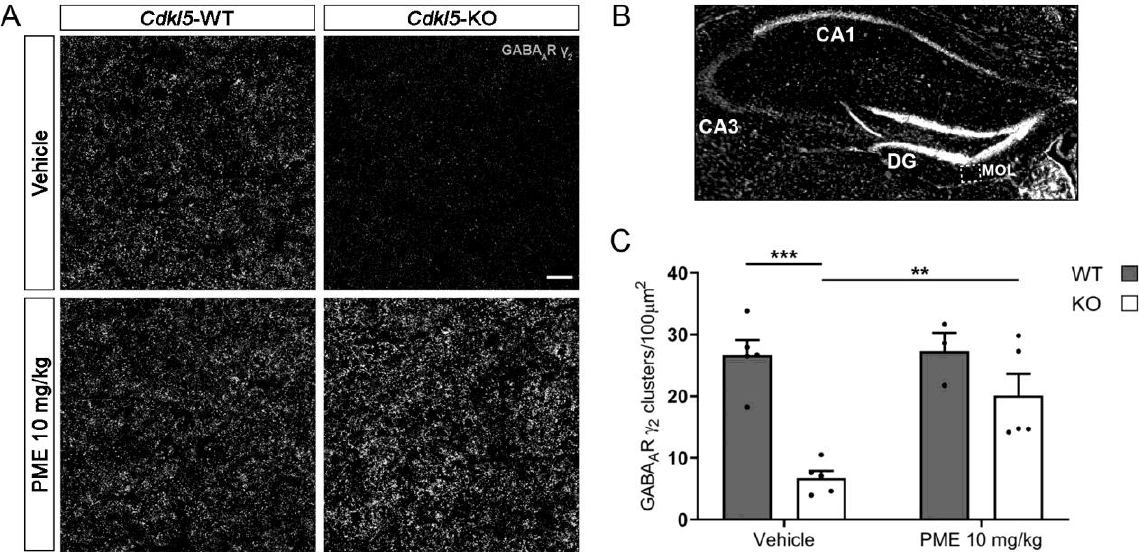
Figure 5. Reduced levels of synaptic GABA A R γ 2 in hippocampi of Cdkl5 -KO mice are normalised upon treatment with PME. ( A ) Hippocampal slices (dentate gyrus) from Cdkl5 -WT/KO male mice treated with PME (10 mg/kg, s.c. for seven days starting from PND60) or sesame oil (vehicle) were stained for GABA A R γ 2 . Scale bar, 5 µ m. ( B ) Representative image of a hippocampal section stained with the nuclear dye DAPI. Images from the molecular layer (MOL) of the dentate gyrus (DG) were used for the analyses shown in panels A and C. ( C ) Graph showing the quantification of GABA A R γ 2 clusters/100 µm 2 . n ≥ 3 . Mean±SEM, ** p < 0.01, *** p < 0.001. Two-way ANOVA followed by Tukey’s post -hoc.